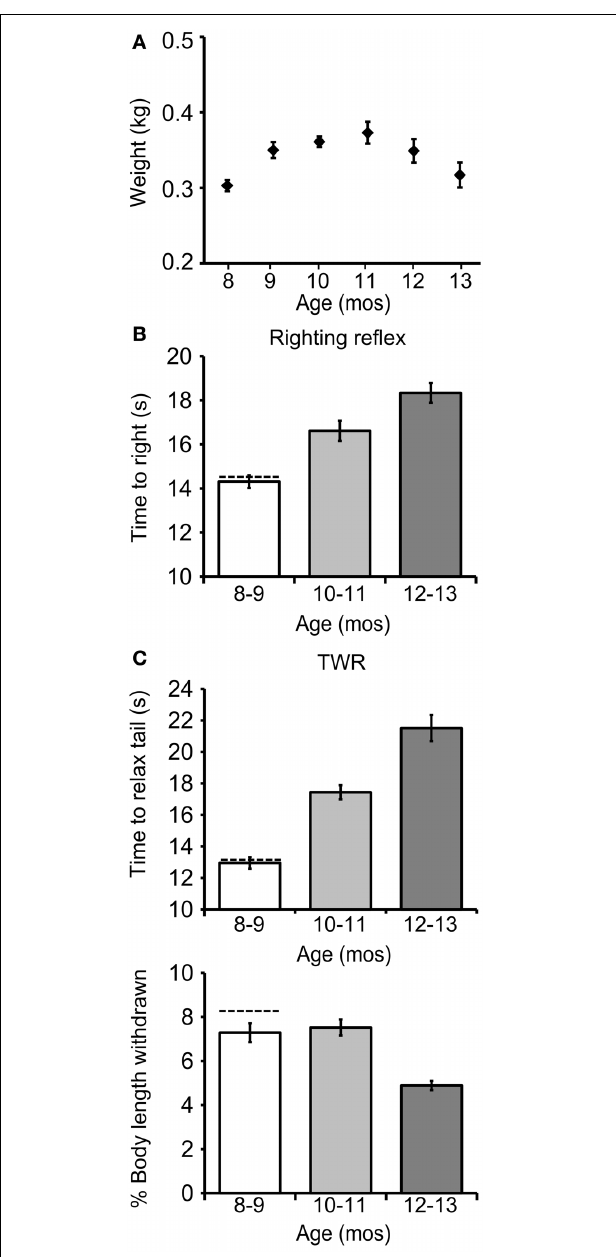
FIGURE 2 | The righting and tail withdrawal reflexes declined during aging. (A) Weights for cohort 1 at age 8–12 mos (all data presented as mean ± SE). (B) The time to right increased significantly with age [ p ≤ 0 . 0001, F (2 , 98) = 19 . 1, repeated measures ANOVA]. (C) The time to relax tail following tail touch, a measure of the duration of the TWR, increased significantly with age [ p ≤ 0 . 0001, F (2 , 98) = 51 . 5]. The fraction of starting body length withdrawn following tail touch, a measure of the amplitude of the TWR, declined significantly with age [ p ≤ 0 . 0001, F (2 , 98) = 11 . 8; n =